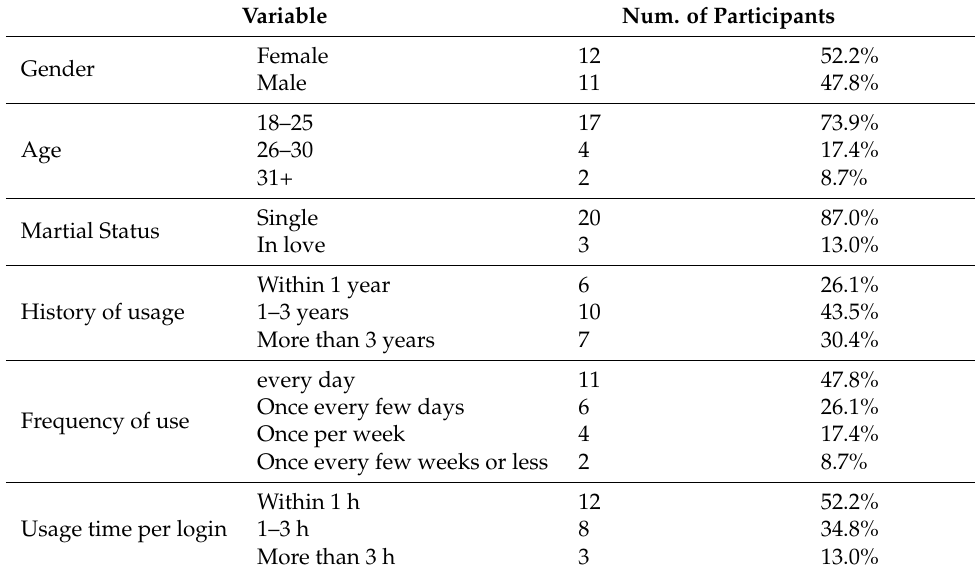
Table 1. Demographic Information.